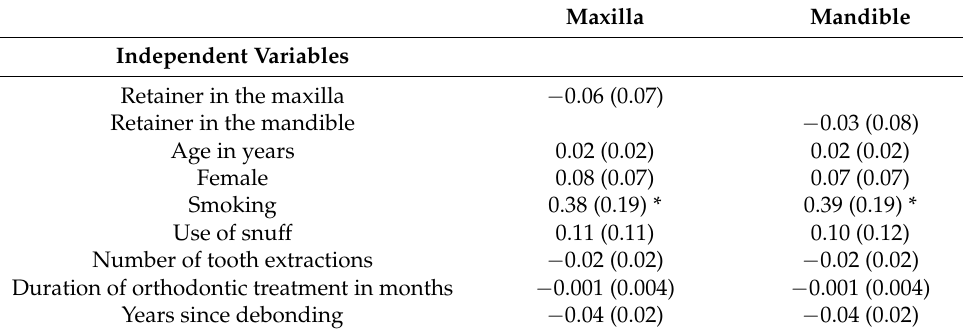
Table 5. Predictors of patient-reported gingival